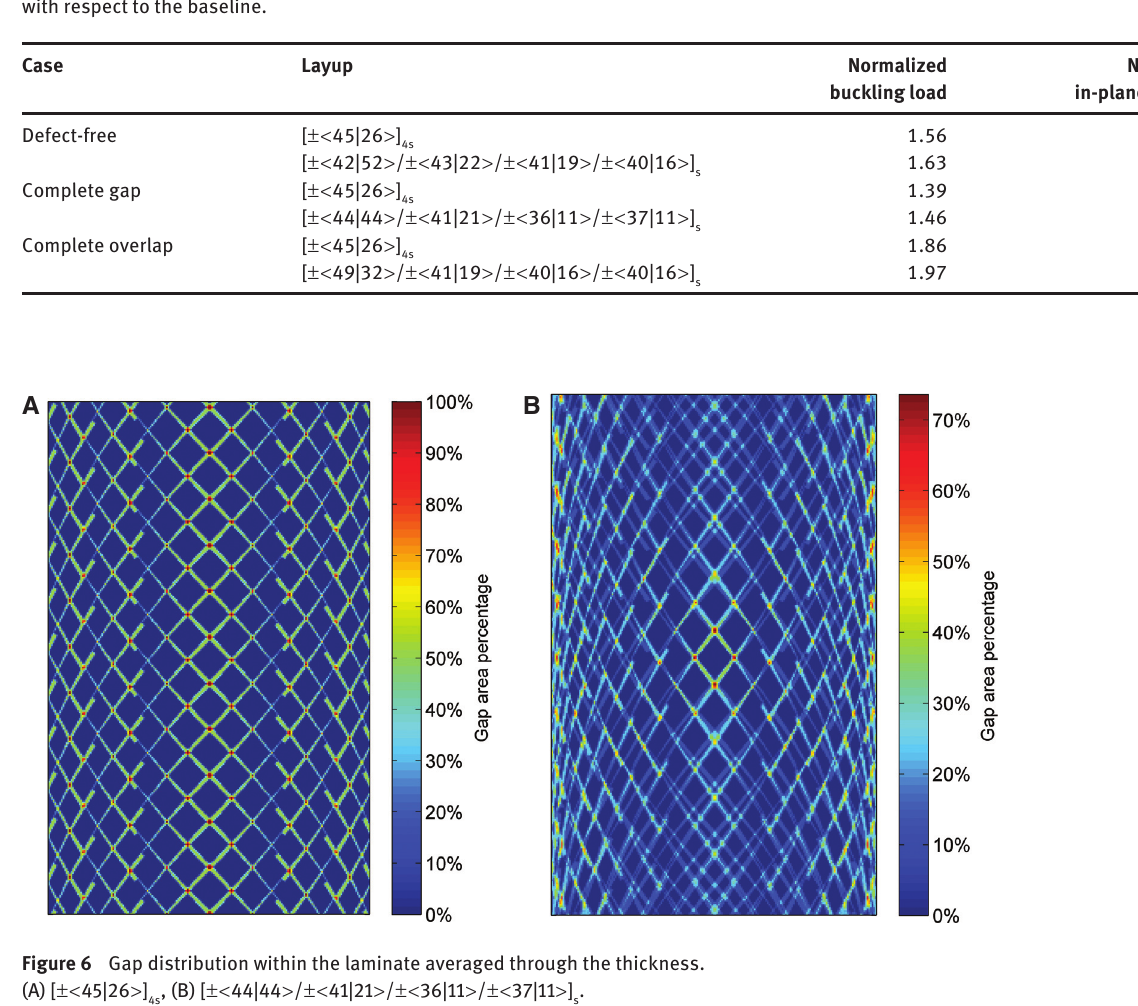
and [ ± θ ( x )/ ± θ ( x )/ ± θ ( x )/ ± θ ( x )] layups normalized 4 s 1 2 3 4 s